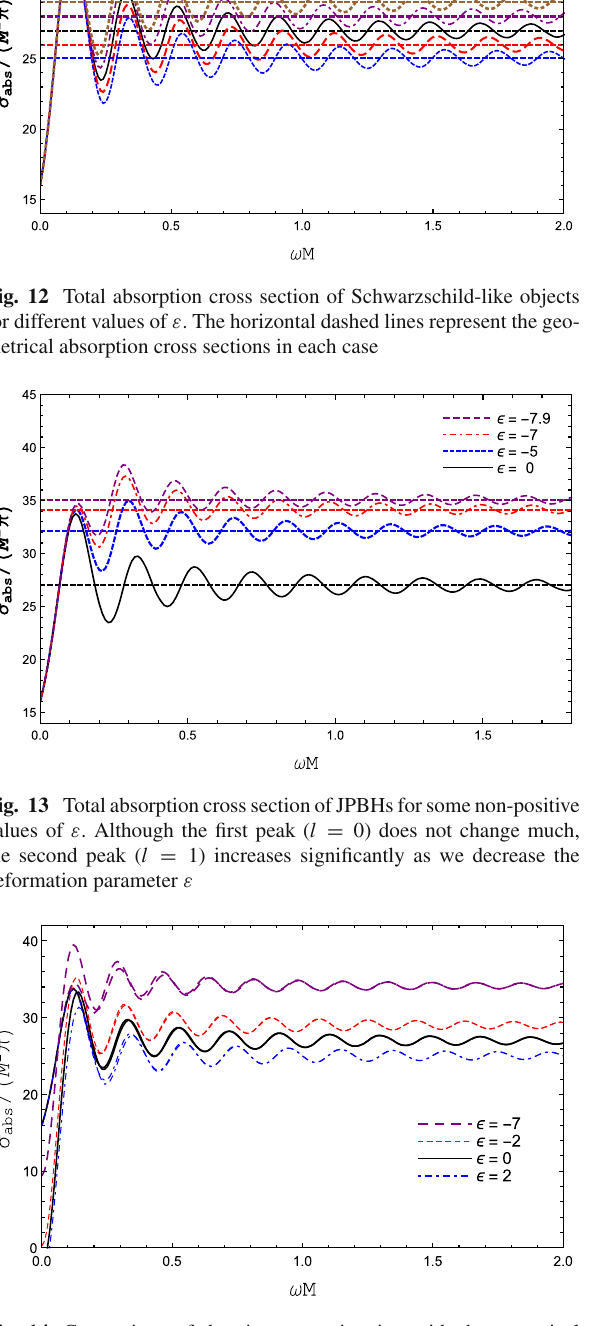
tion of the lowest mode l = 0, being equal to the area of the event horizon. We notice that the same happens to the JPBH, independently of the non-vanishing deformation